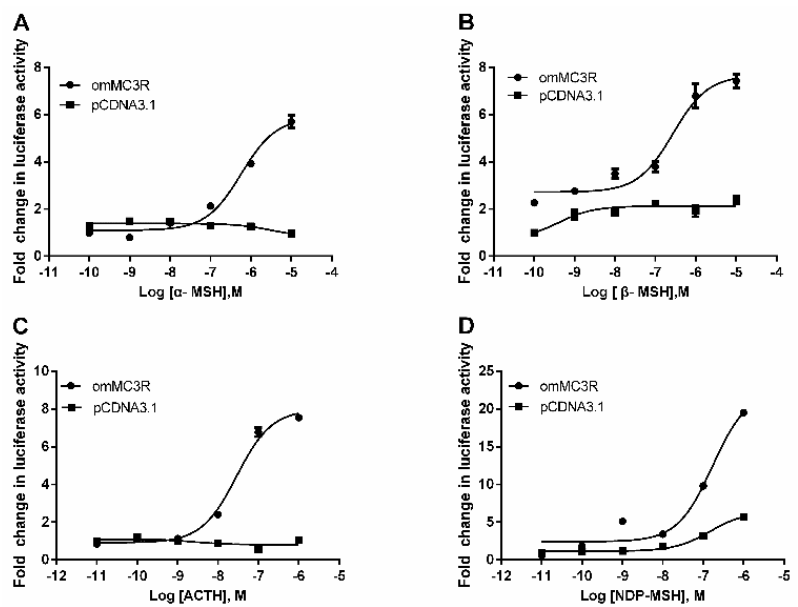
Figure 5. Activation of cAMP signaling mediated by omMc3r. The pGL4-CRE luciferase reporter system (pGL4.29 vector) was used to monitor the effects of α -MSH ( A ), β -MSH ( B ), ACTH (1–24) ( C ), and NDP-MSH ( D ) on the HEK293T cells transiently transfected with omMc3r expression plasmid, as described in Section 2. The results were presented as fold change of the agonist-treated groups relative to the DMEM serum-free medium-treated group. The empty vector pcDNA 3.1 was used as a negative control. Each data point represents mean (SD) of three independent experiments.